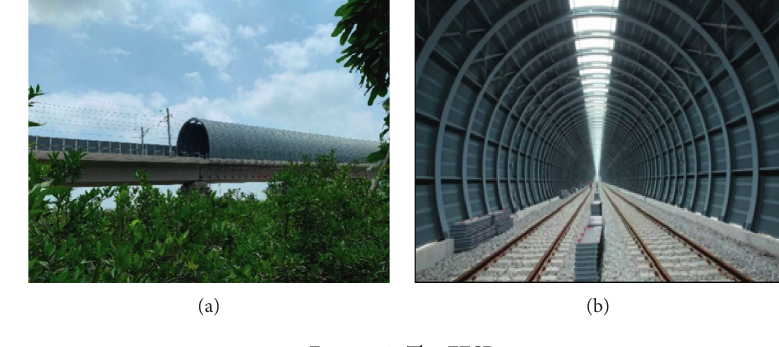
Figure 1: The FESB.